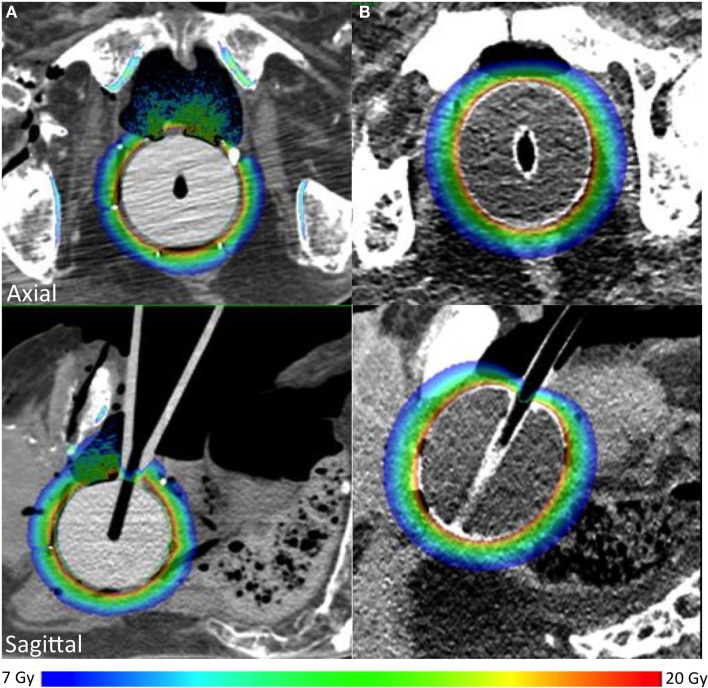
Dose distribution in targeted tissues using Zeiss Intrabeam™(A) or Xoft Axxent™(B).